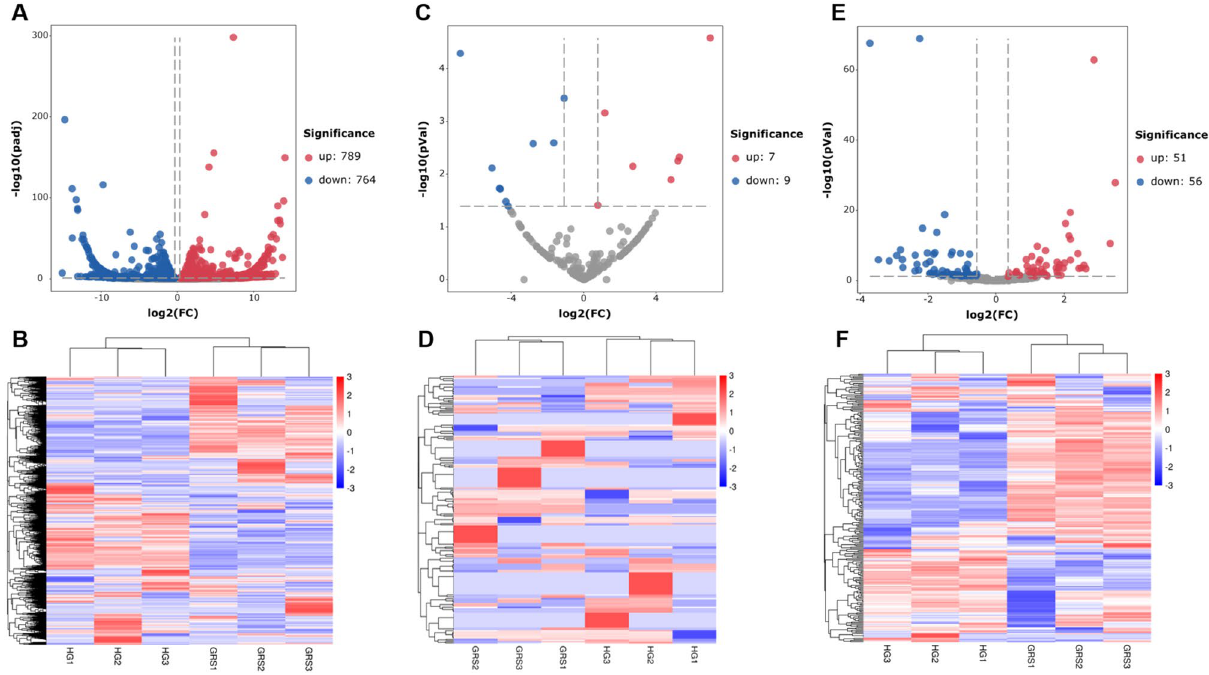
Figure 4. Expression profiling changes of ncRNAs in diseased tissues (the data used in heatmaps are Z-score of expressions). ( A ) Volcano plot indicating upregulated and downregulated; ( B ) heatmap of lncRNAs; ( C ) Volcano plot indicating upregulated and downregulated circRNAs; ( D ) heatmap of circRNAs; ( E ) Volcano plot indicating upregulated and downregulated miRNAs; ( F ) heatmap of miRNAs. GRS: ginseng rusty root symptom; HG healthy ginseng. Image generated with R 3.6.3 (https:// www.R- proje ct. org) 51 pheatmap package (https:// cran.r- proje ct. org/ web/ packa ges/ pheat map/) and ggplot2 package (https:// ggplo t2. tidyv erse.